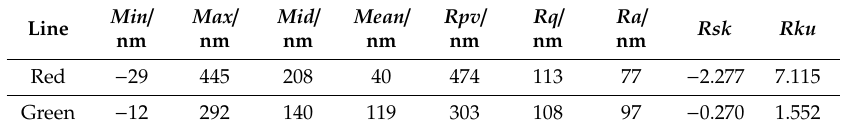
Figure 13. ( a ) 2D topography of the surface on which BTA was deposited (30 × 30 μ m); BTA deposition surface line profiles: ( b ) red and ( c ) green; ( d ) the 3D surface topography of the glass plate coated with BTA. Table 11. Statistics of the quantities characteristic of the roughness on the lines on the BTA surface.